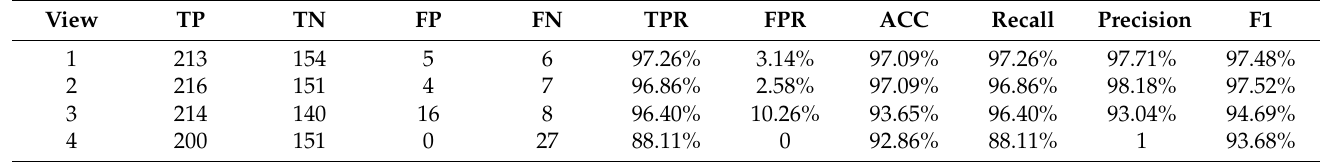
Table 2. The detection results for four views of the proposed